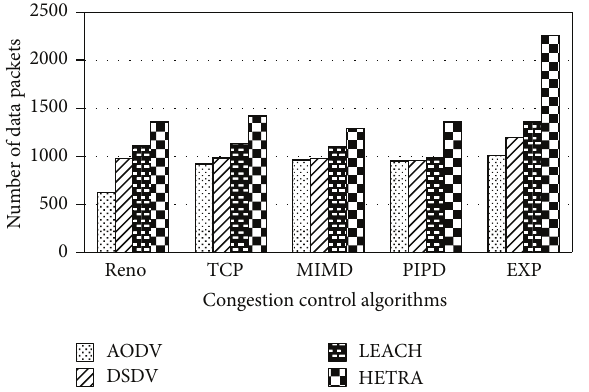
Figure 6: Number of data packets for Pattern 1.